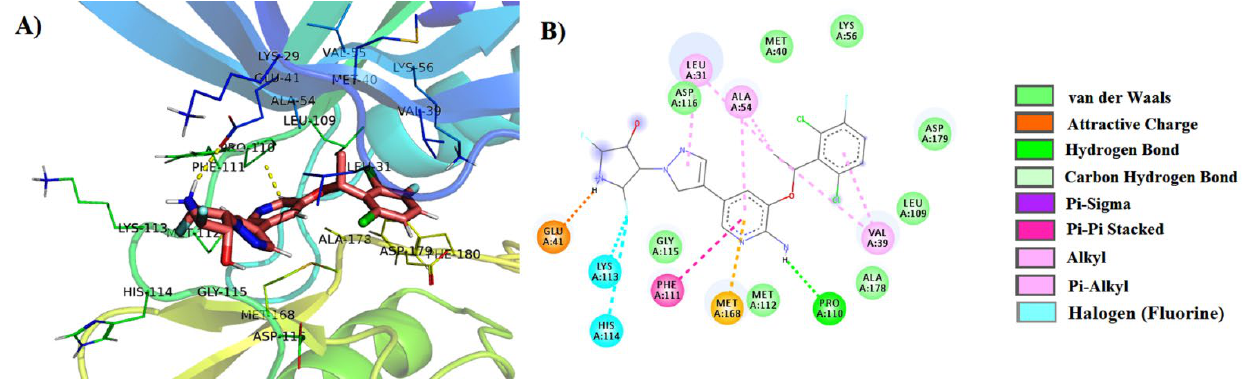
Figure 8. ( A ) Molecular dynamics simulations of AXL-PubChem-78160848complex active site from the average structure of last 10 nanoseconds of 100 nanoseconds. ( B ) PubChem-78160848 molecule interaction types with AXL kinase active site residues. Protein amino acids are shown with lines, and ligand molecules are shown with the stick model. Hydrogen bonds are shown in yellow (broken lines).